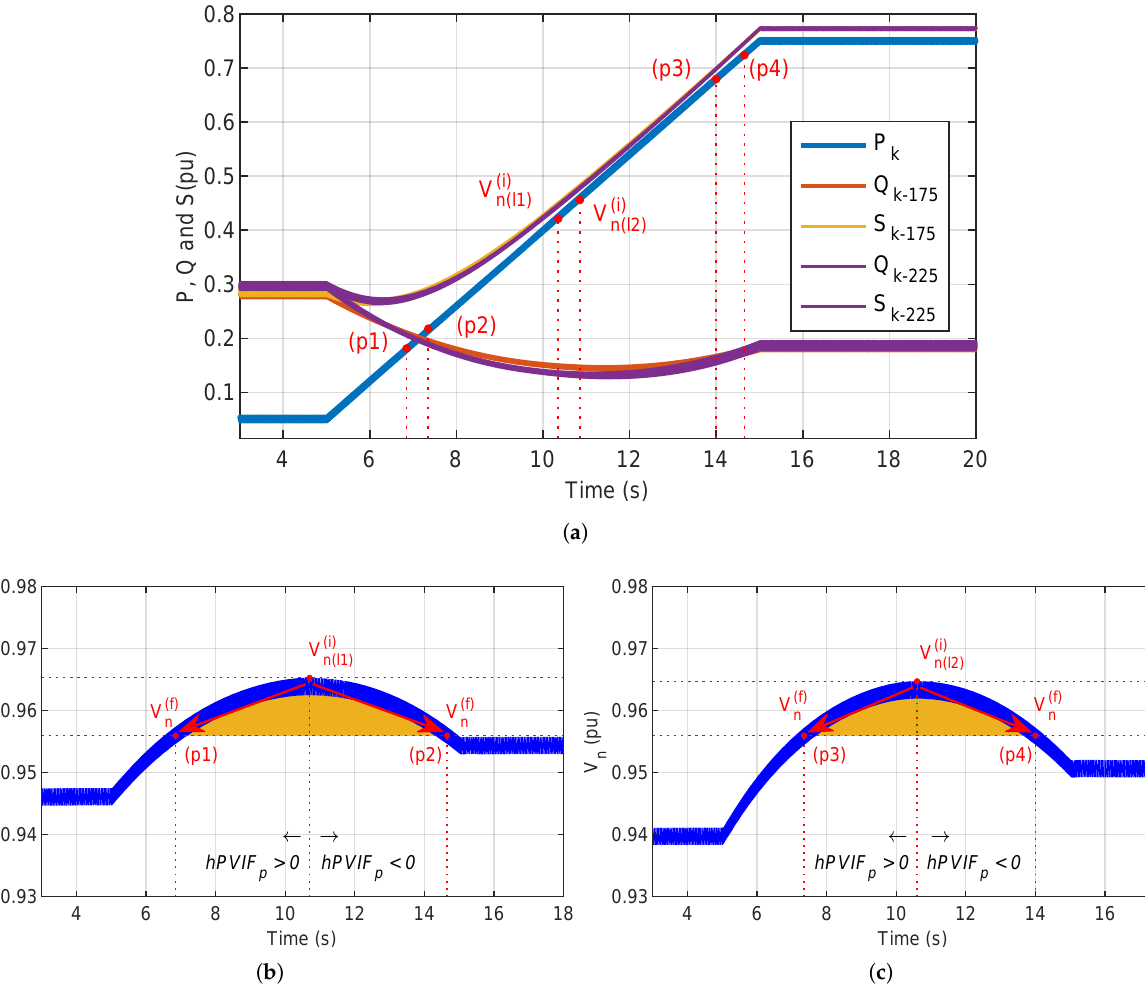
Figure 11. LCC-HVDC inverter station AC bus voltage as function of (cid:126) S k : ( a ) VSC-HVDC powers of inverter station. ( b ) LCC-HVDC AC voltage for 175 km. ( c ) AC LCC Voltage for 225